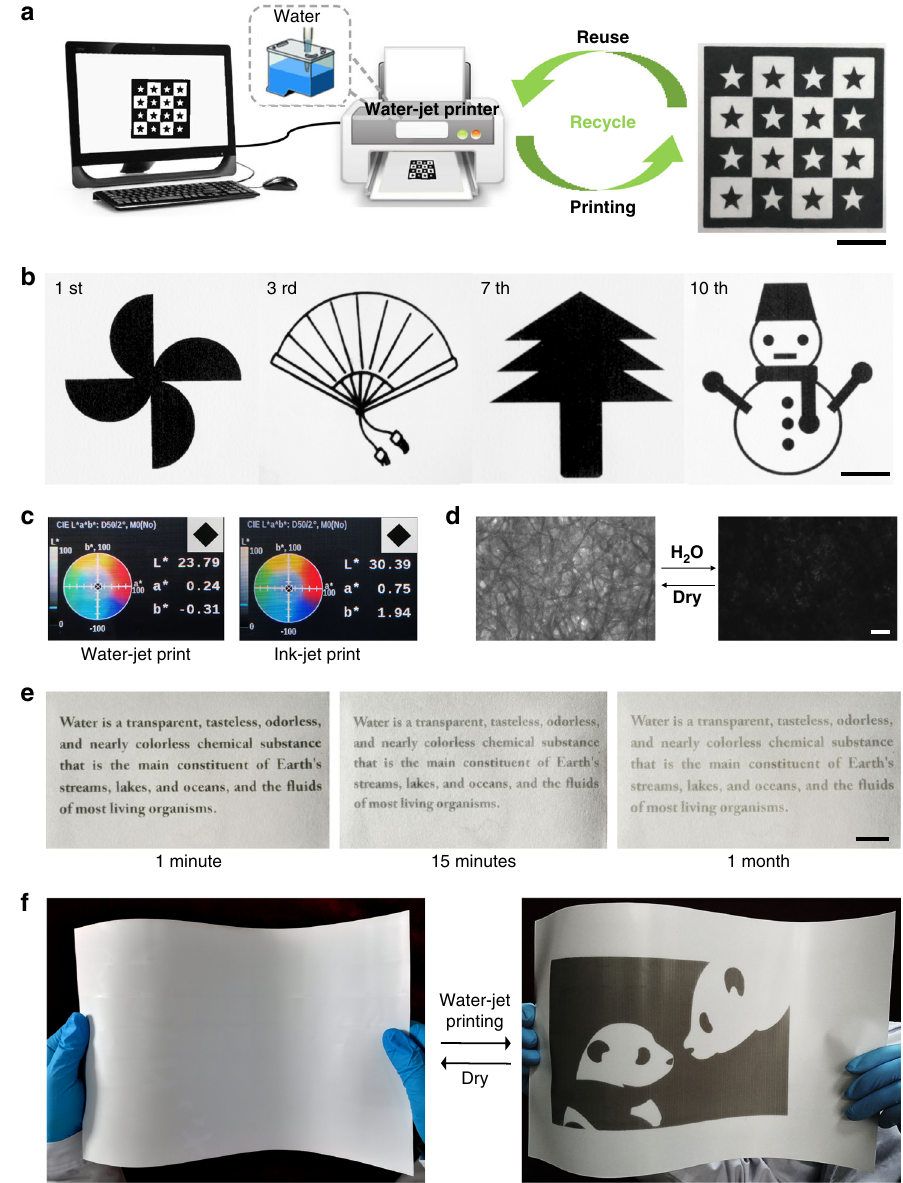
Fig. 4 Repeatability, resolution, colour intensity and retaining time of water-jet prints. a Schematic illustrations of a printing-erasing cycle of WJRP printed with water-jet printer, scale bar = 1 cm. b Photographs of patterns printed on WJRP after 10 consecutive writing-erasing cycles (scale bar = 1 cm). c L*, a*, b* measured by spectrodensitometer and photographs of water-jet prints and ink-jet prints, respectively. d Microscopic images of WJRP before and after addition of water, scale bar = 200 µ m. e Photographs of WJRP maintaining in ambient air after printing as time passed by, scale bar = 5 mm. f WJRP based on PET substrate before and after printed with water, scale bar = 2